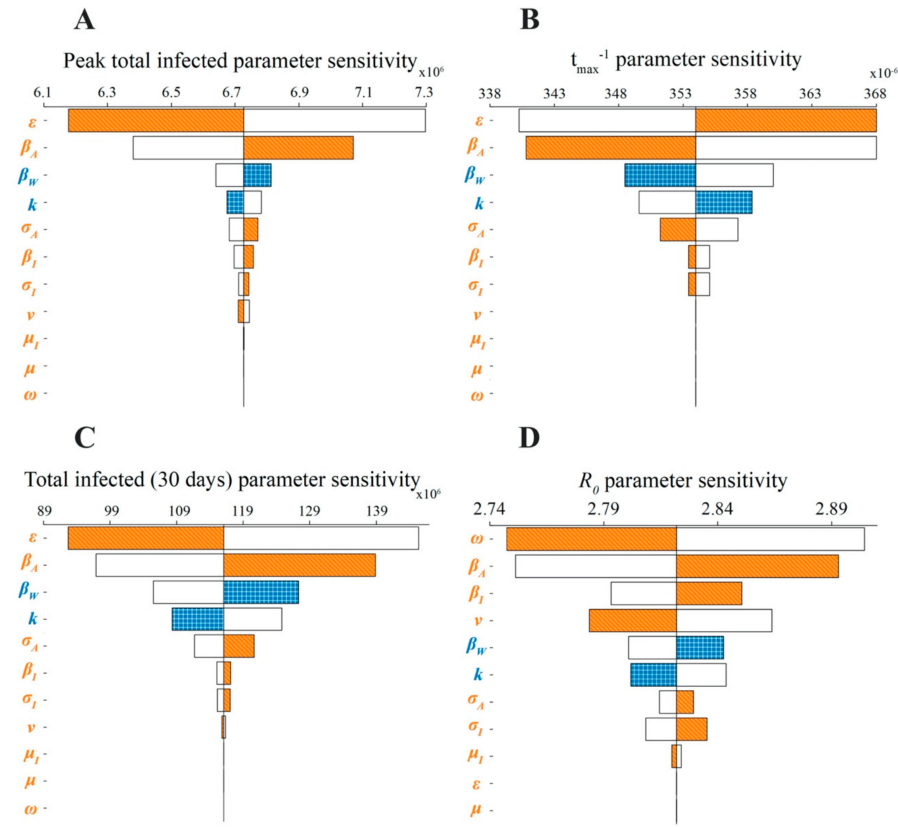
Figure 2. Tornado plot showing the sensitivity of epidemic properties to individual parameter changes: ( A ) the number of infected individuals (asymptomatic and symptomatic) at the epidemic peak; ( B ) the rate at which the epidemic peak is reached, t max − 1 ; ( C ) the total infected population after 30 days; and ( D ) the basic reproductive ratio ( R 0 ). Filled bars indicate the value of the epidemic feature when the associated parameter is increased by 5.0% from its nominal value. White bars indicate the value of a feature when the associated parameter is decreased by 5.0%. Blue coloring with checkered patterning indicates a parameter associated with survival, and orange coloring with lined patterning indicates a parameter associated with virulence.